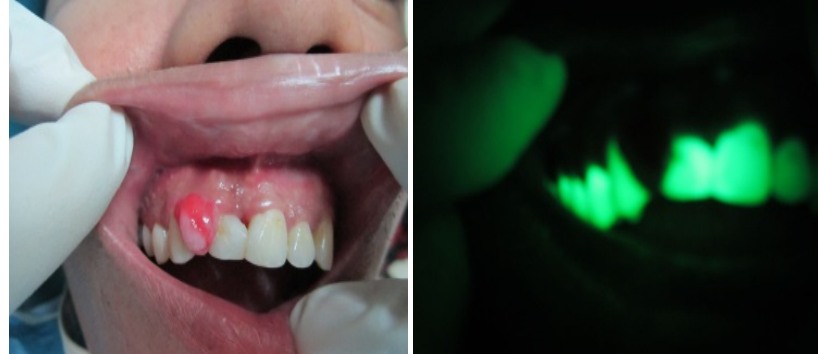
Figure 6. VELscope ® images without the Canon A620 settings; the field of view (FOV) is quite blurred and not as focused as in RGB frames.